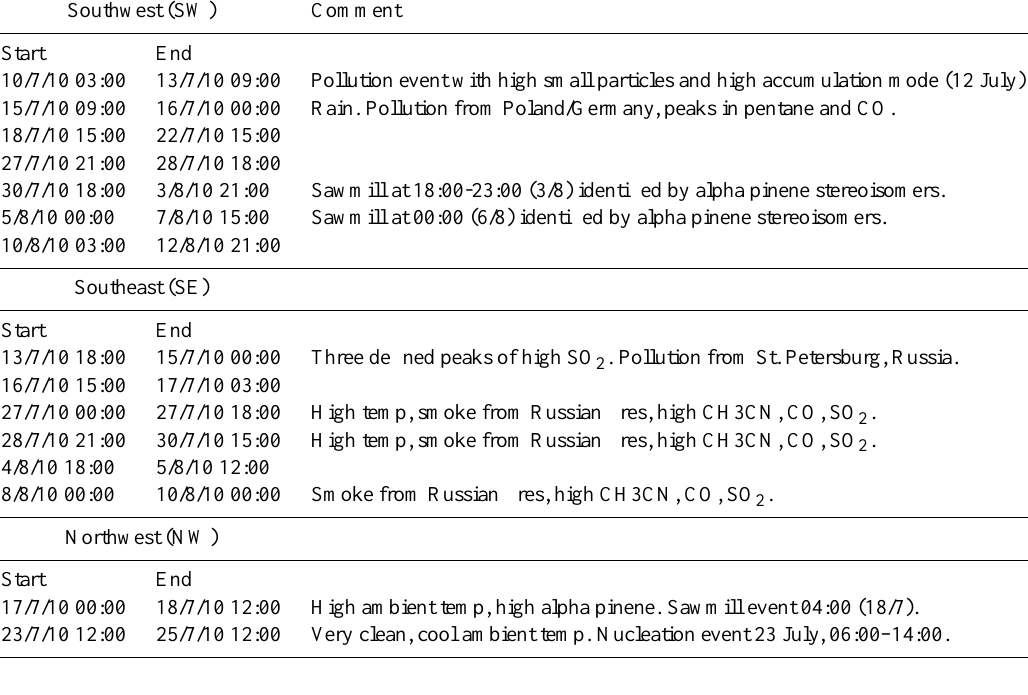
Table 2. Time periods are tabulated according to wind sector alongside key events noted within these time periods. Southwest (SW)